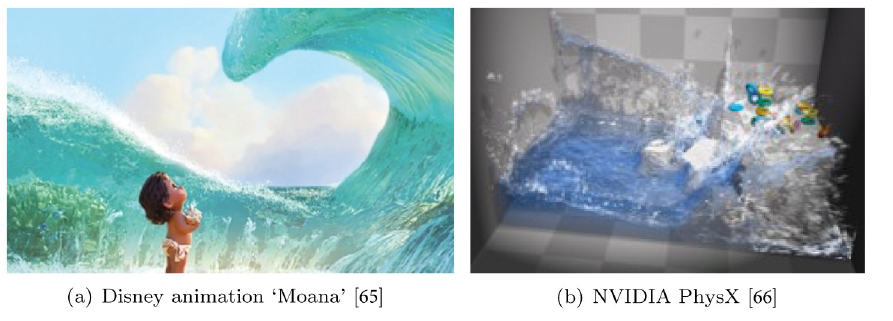
Fig 17. Examples used in film and game. (a) Disney animation ‘Moana’ [65], (b) NVIDIA PhysX